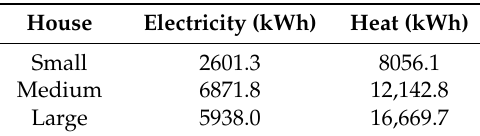
Table 4. Annual demand